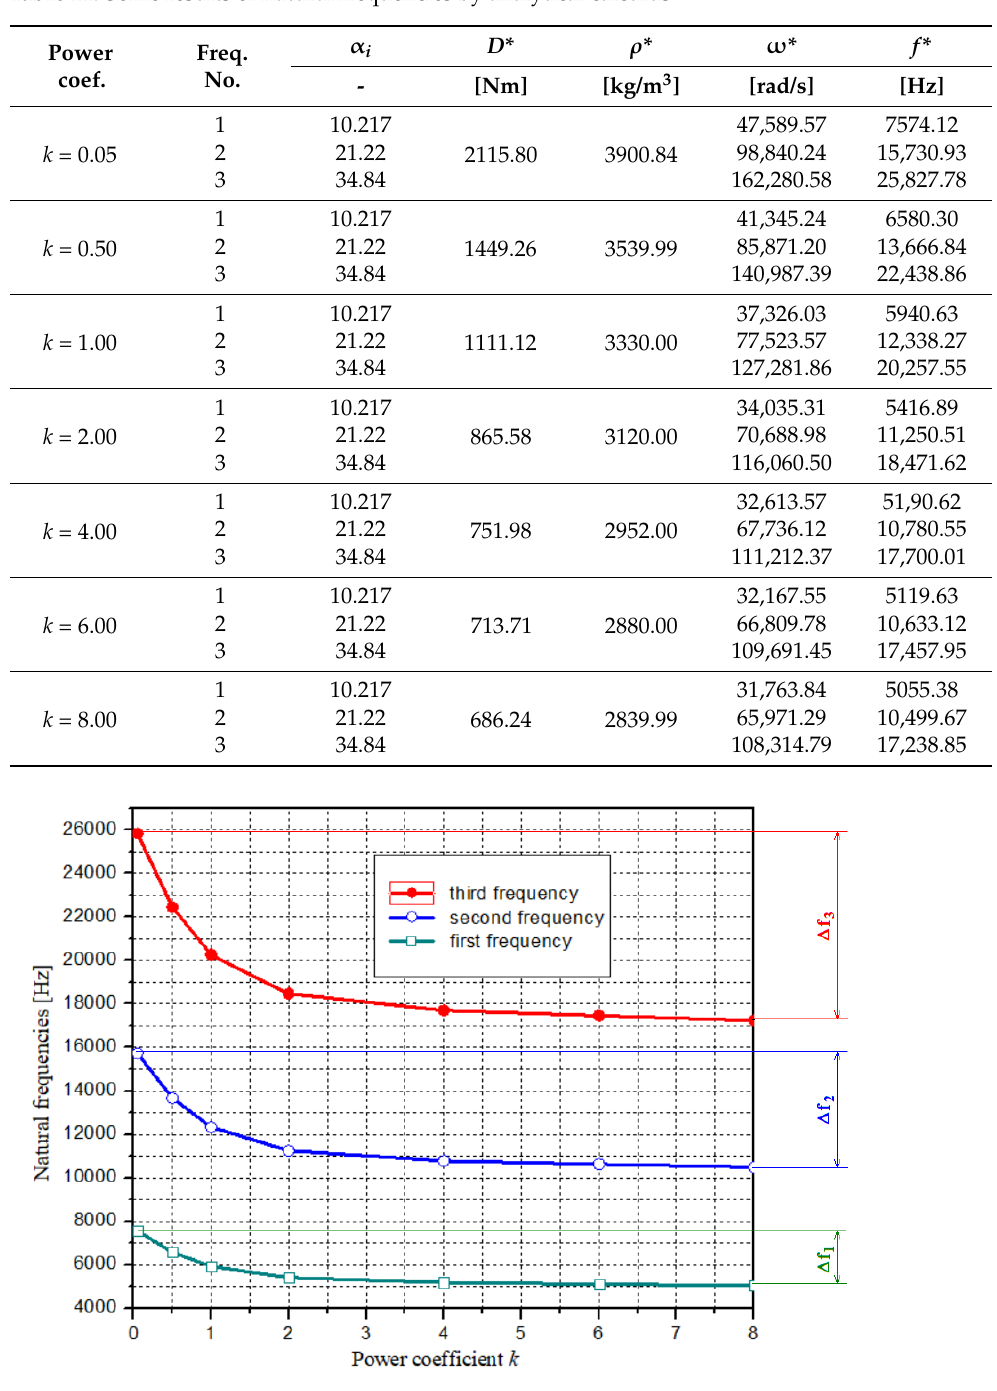
Figure 22. Natural frequencies versus power coefficient k .